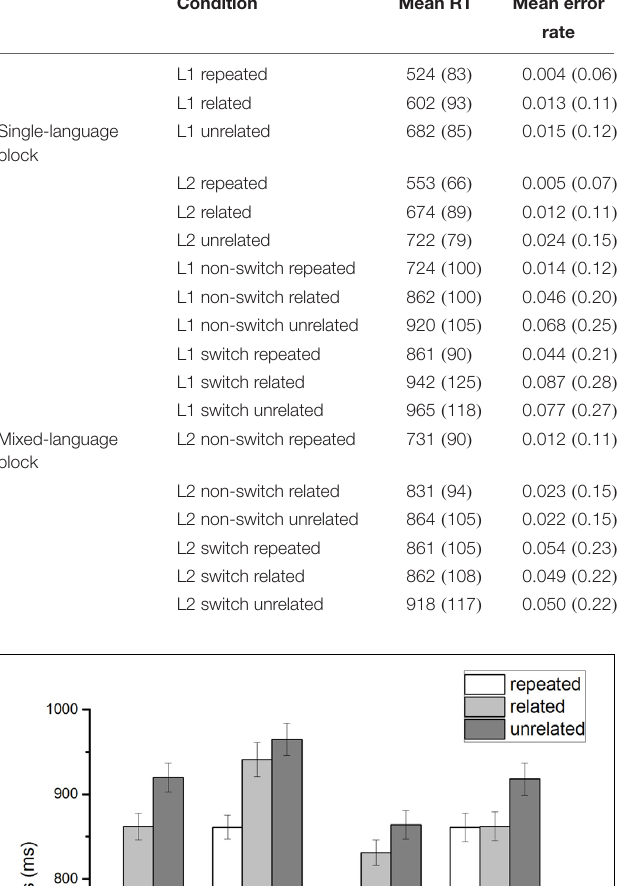
TABLE 2 | Mean reaction times in ms (SD) and error rates (as percentages) presented separately in each condition of the experiment.